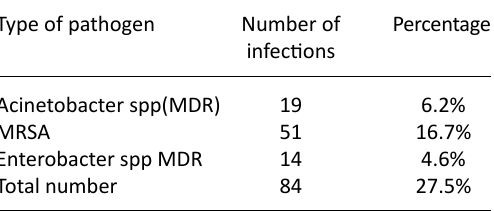
Table 4-A.3. Multidrug-resistant isolates of wound culture